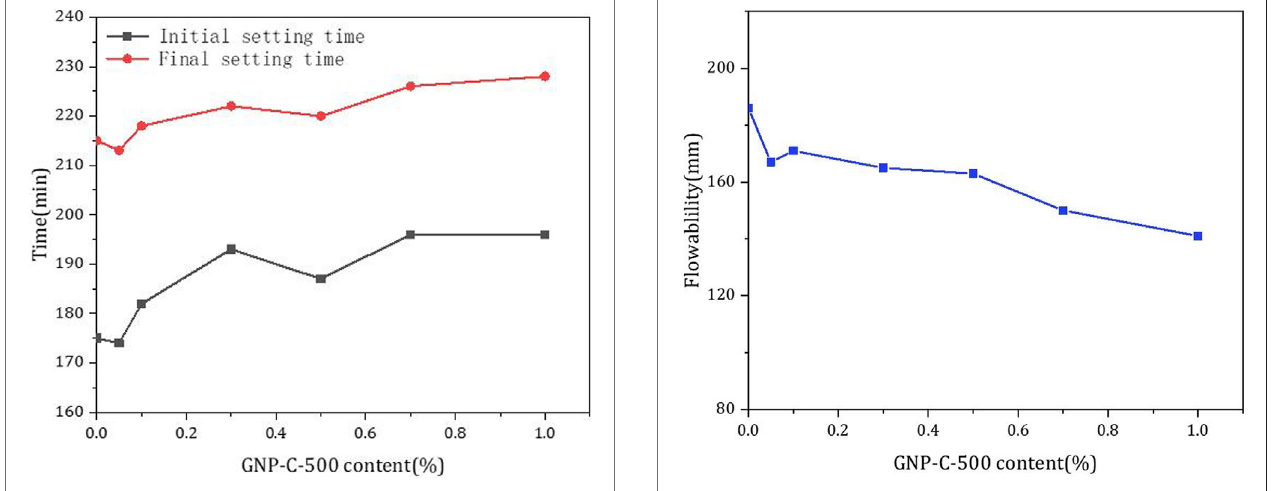
FIGURE 5 | The effects of GNP-C-500 content on setting time. FIGURE 6 | The effects of GNP-C-500 content on fl